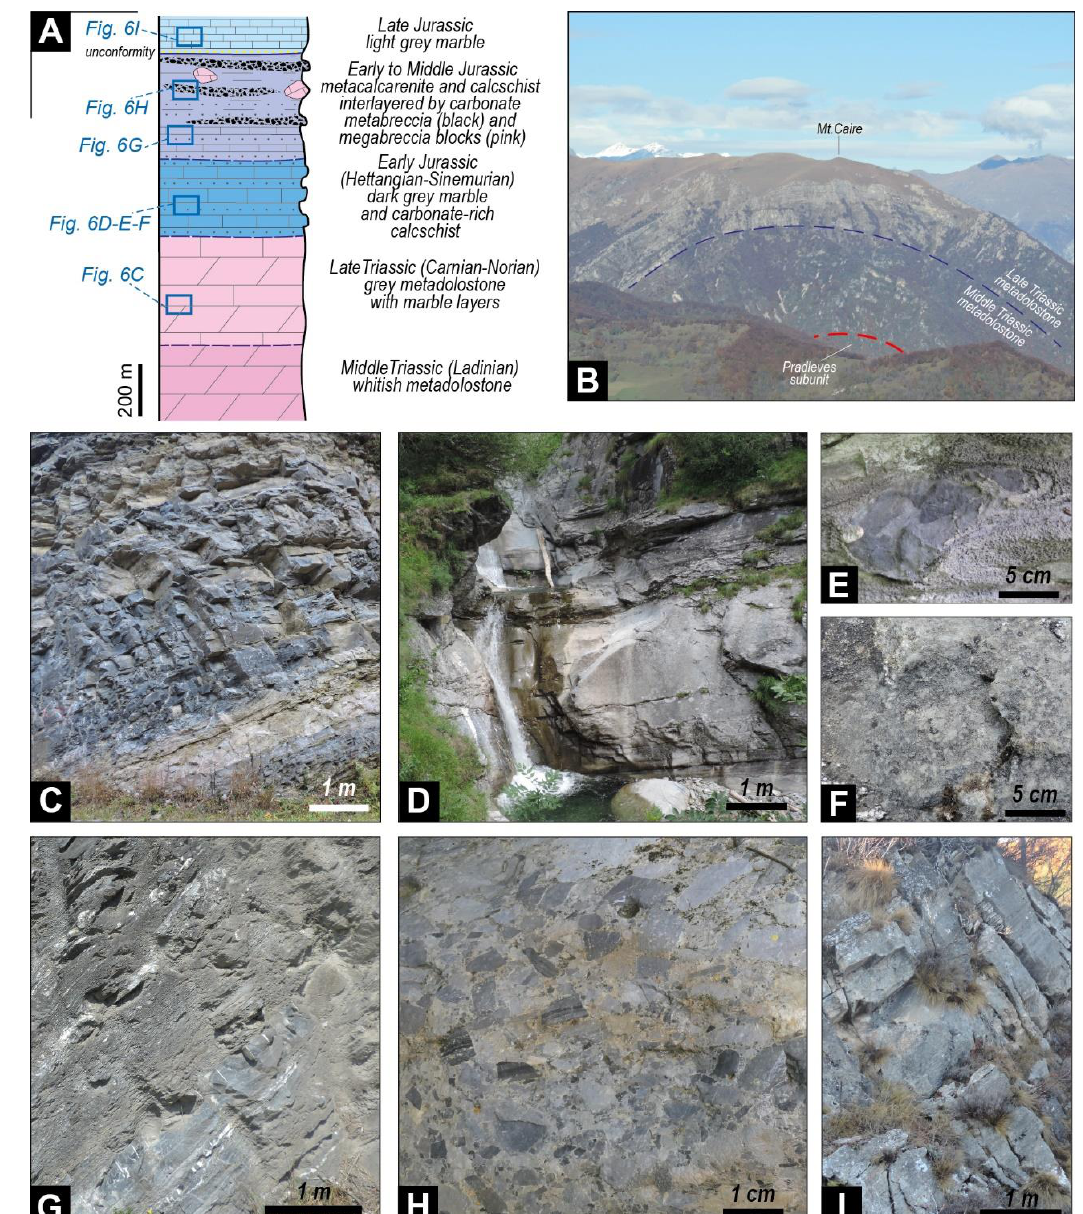
Figure 6. ( A ) Pre-Alpine stratigraphic columnar section of the Grana Unit (the stratigraphic location of the representative field images is shown); ( B ) panoramic view of the Pradleves anticline deforming the lower part of the GU succession and the underlying Pradleves subunit (dashed blue line: contact between the Ladinian metadolostone and the Carnian-Norian metadolostone; dashed red line: tectonic contact between the GU and the Pradleves subunit); ( C ) view of the Carnian-Norian cyclic carbonate metasediments consisting of alternating banded metadolostone and marble layers (South-East of Narbona, along the Grana river); ( D ) view of the ammonite-bearing Sinemurian marble and carbonate-rich calcschist (South-East of Narbona); ( E , F ) close-up views of remnants of recrystallized and partly deformed ammonites (South-East of Narbona); ( G ) view of the alternating Early to Middle Jurassic marble and calcschist (East of Narbona); ( H ) close-up view of an Early to Middle Jurassic poorly matrix-supported metabreccia consisting of angular clasts of metadolostone and marble in a carbonate matrix (Narbona); ( I ) view of the Late Jurassic light grey marble (South of Celle di Macra).